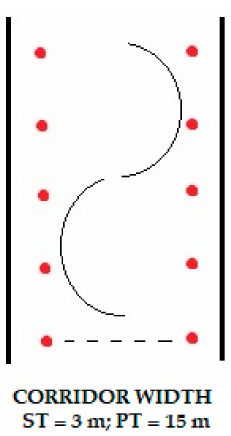
Figure 2. Display of the